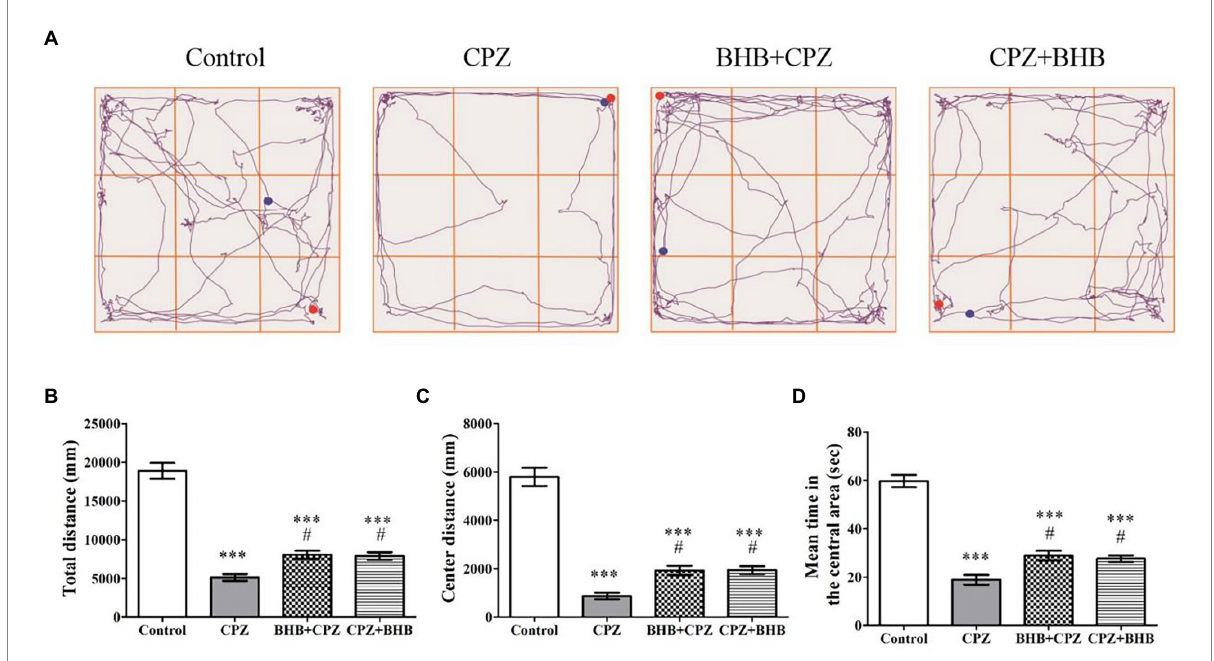
FIGURE 3 OFT behavioral assessment. (A) Representative images show typical examples of mice trajectories in the OFT at 35 days after CPZ induction; blue dots represent the starting point and red dots represent the final point. Total distance traveled (B) , distance traveled in the central zone (C) , and time spent in the central area (D) were compared among control, CPZ, BHB + CPZ and CPZ + BHB groups. Data are presented as mean ± SEM. N = 10 mice/group. *** p < 0.001 versus the control group; # p < 0.05 versus the CPZ